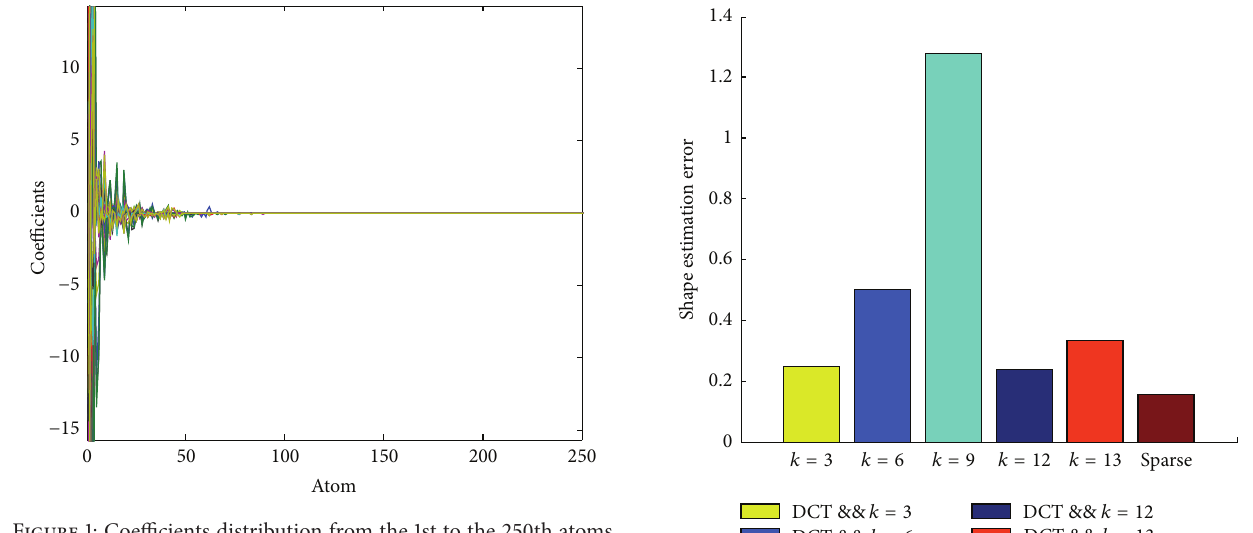
Figure 1: Coefficients distribution from the 1st to the 250th atoms on the “Yoga” sequence (better viewed in color).